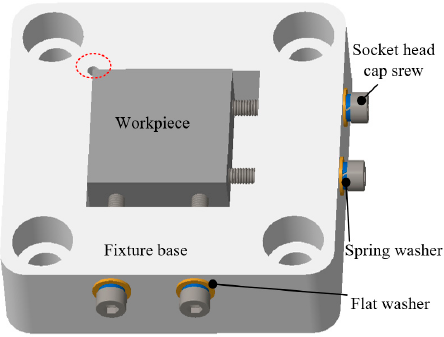
Figure 6. The structure of the workpiece fixture.